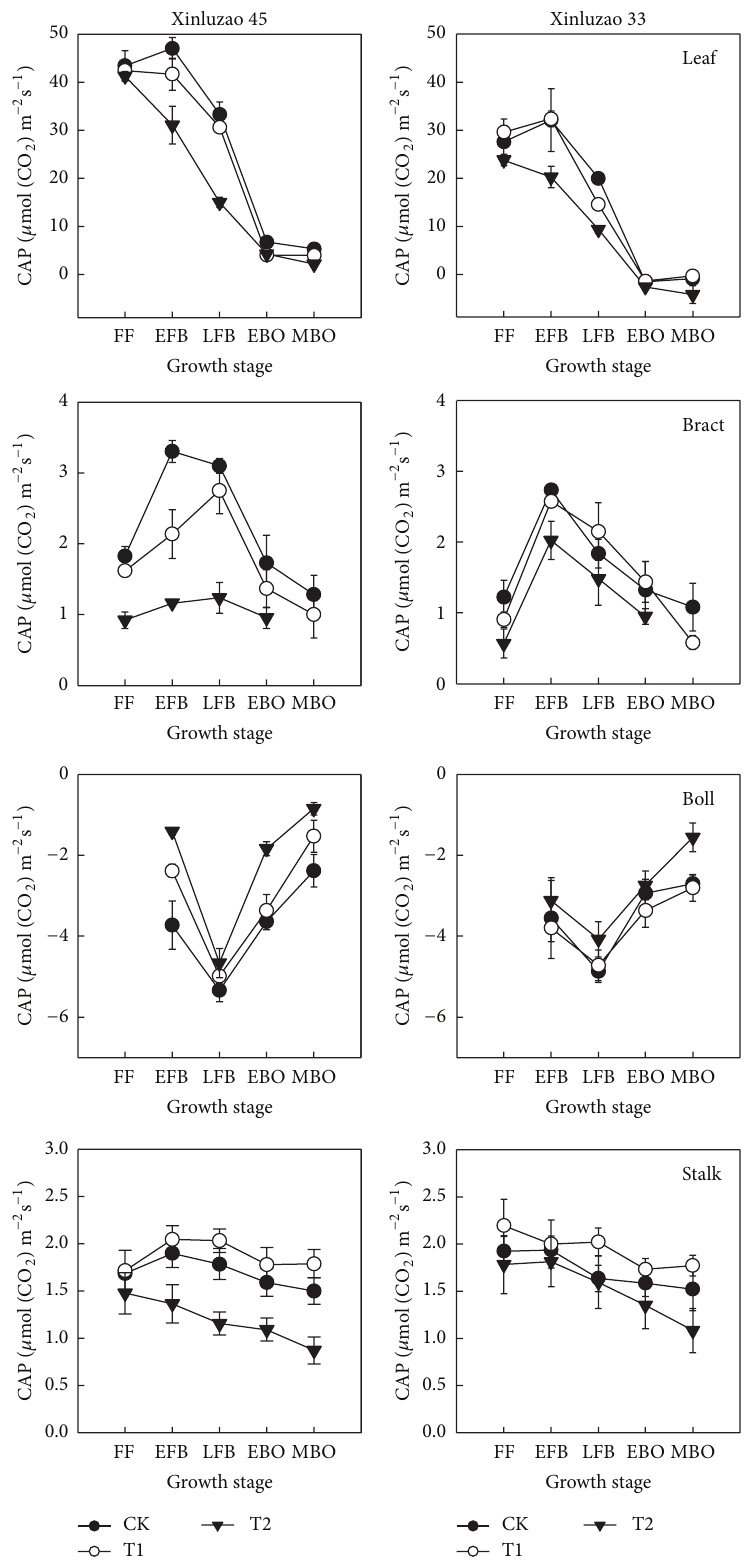
Figure 3: Temporal changes in canopy apparent photosynthesis of each cotton plant organ in 2013. CK: conventional irrigation; T1: slight deficit irrigation; T2: moderate deficit irrigation. FF: full flower; EFB: early full boll; LFB: late full boll; EBO: early boll open; MBO: medium boll